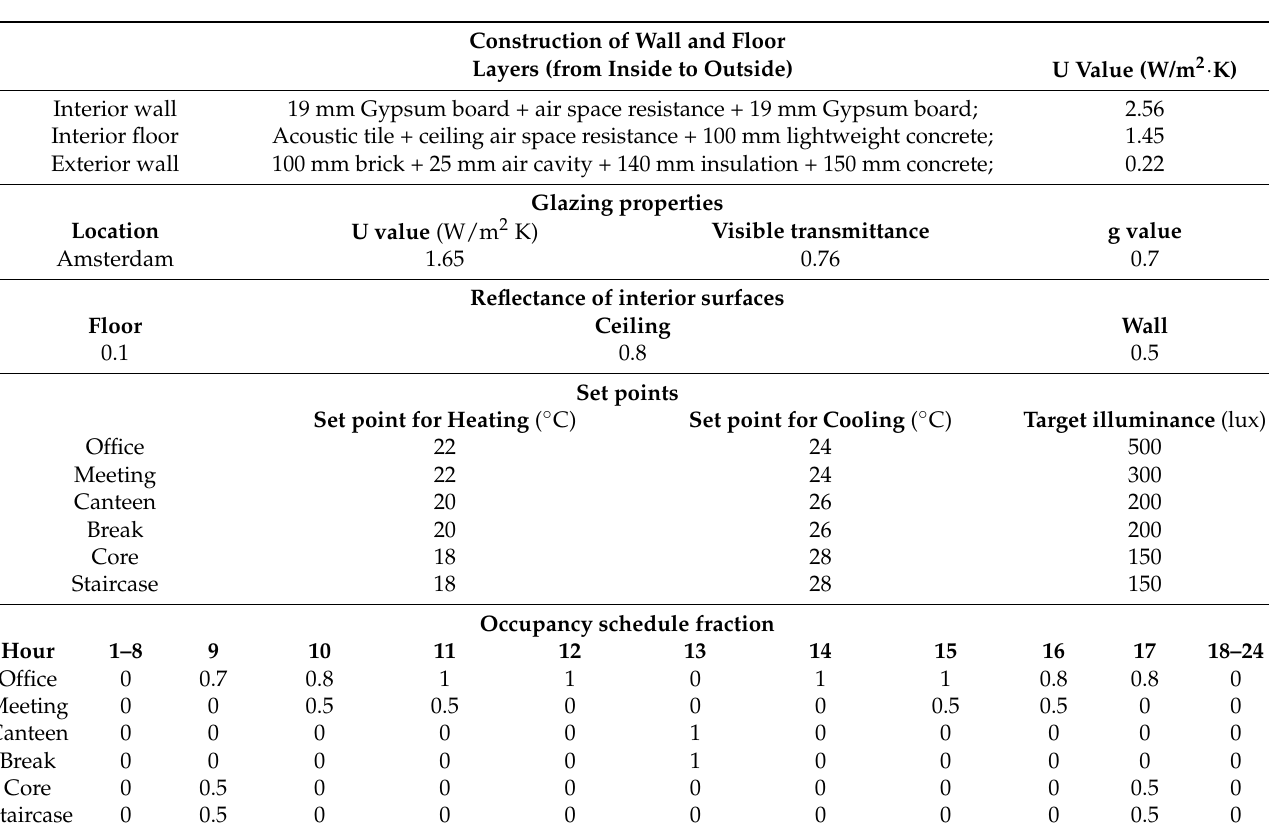
Table 1. Detailed information for simulation, adapted from